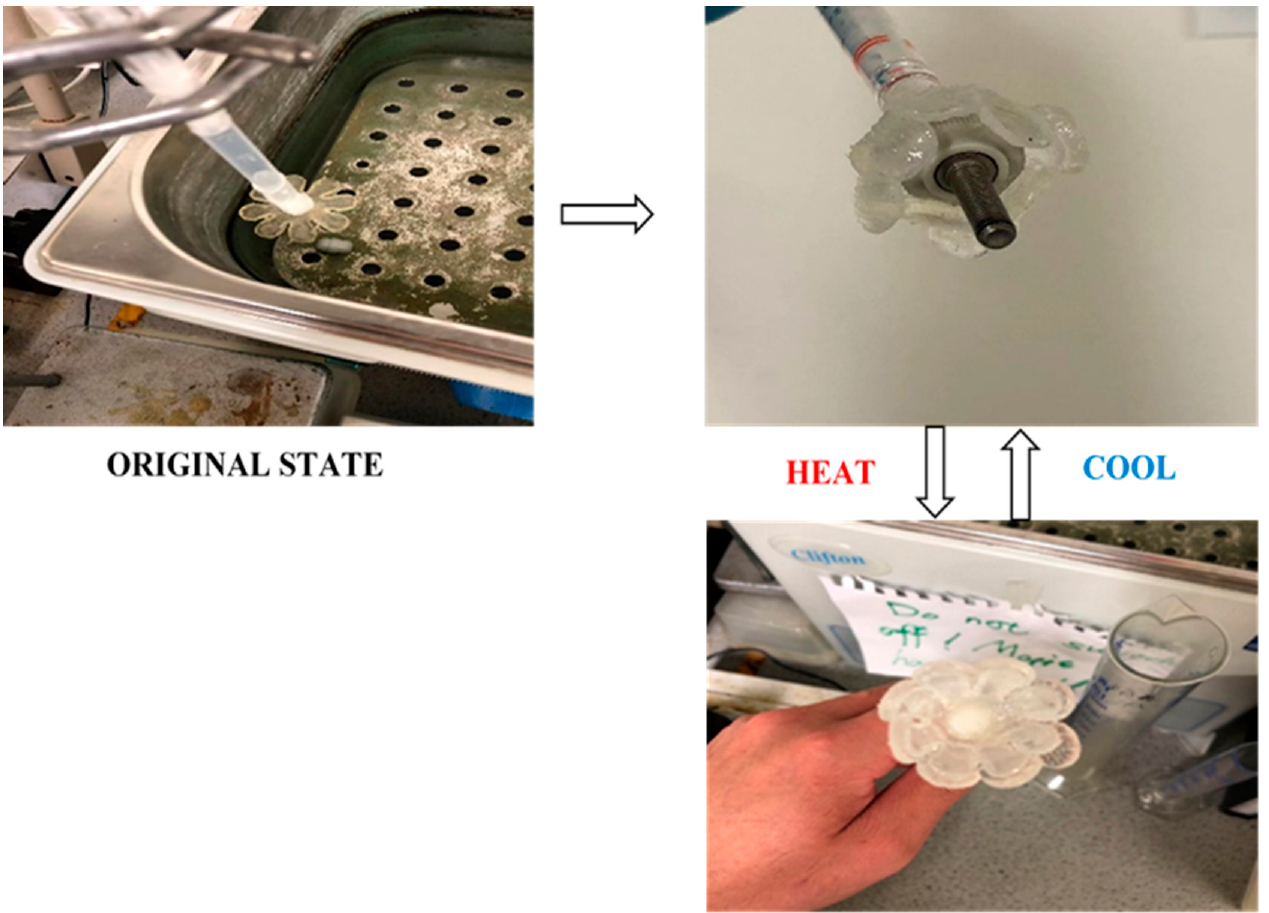
Figure 13. The fl ower gripper achieved by using bilayer fl owers. Figure 13. The flower gripper achieved by using bilayer